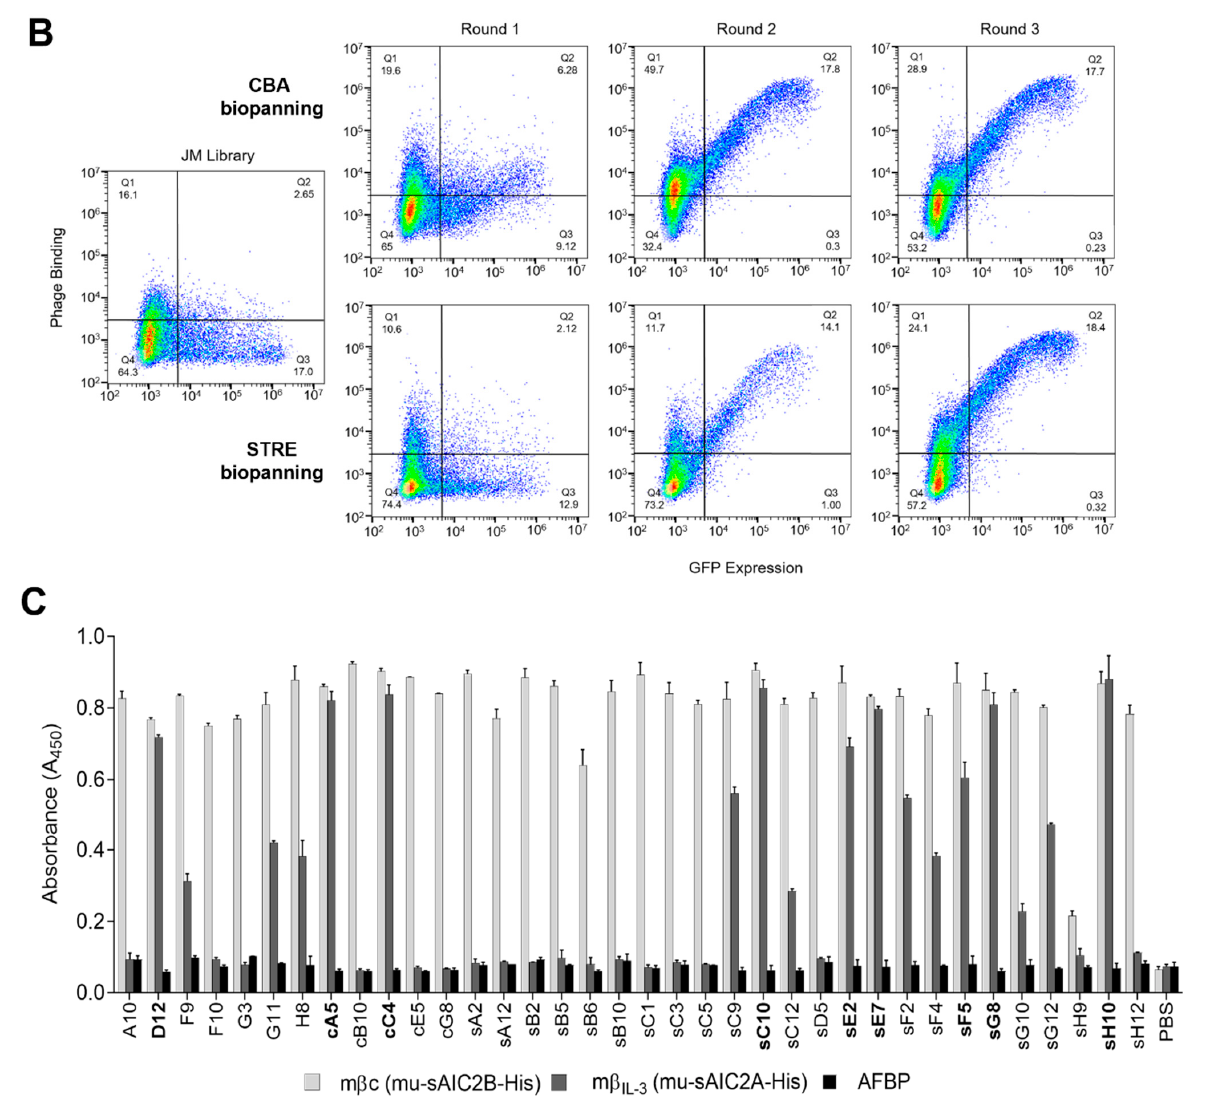
Figure 2. Binding analysis of STRE and CBA biopanning derived phage pools and individual phage clones. ( A ) Polyclonal phage ELISA against the recombinant antigens m β c (mu-sAIC2B-His, positive) and m β IL-3 (mu-sAIC2A-His, negative). Phage pools from all three CBA (cR1-cR3) and STRE (sR1-sR3) rounds were compared to the naïve Jones-Mahler (JM) library. Binding was assessed with successive 10-fold dilutions of phage particles. ( B ) Polyclonal flow cytometry analysis of